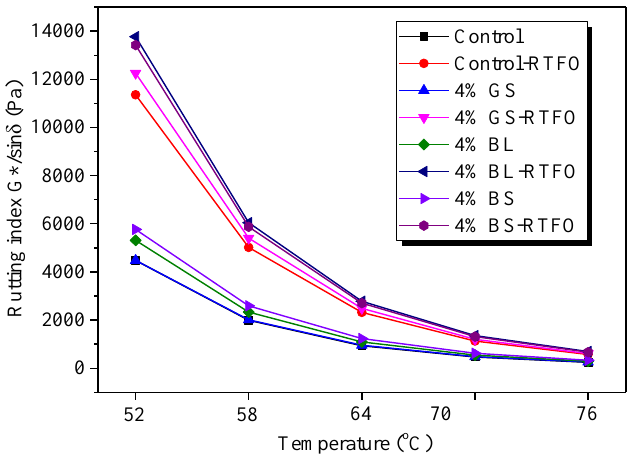
Figure 5. Rutting indexes (G*/sin δ ) of different types of asphalt binders.